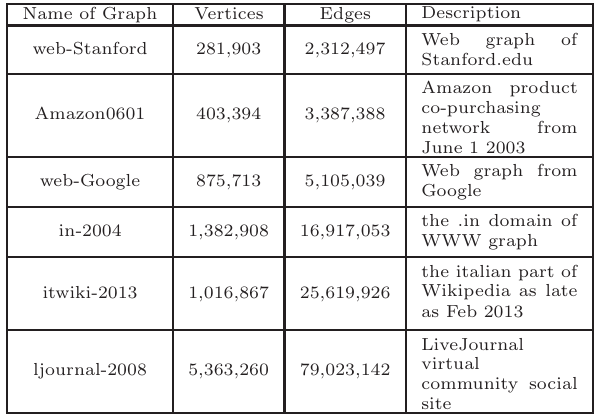
Table 2. Graph Datasets